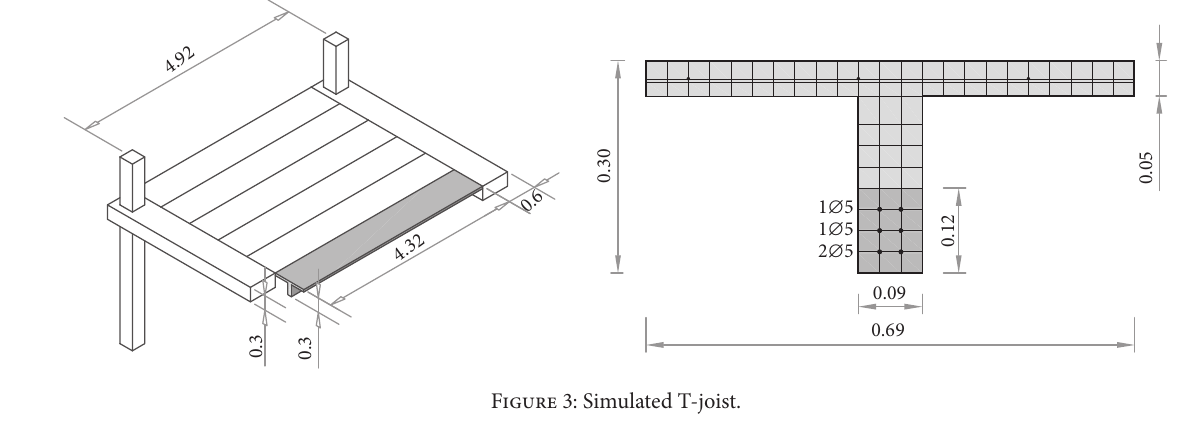
Figure 3: Simulated T-joist.